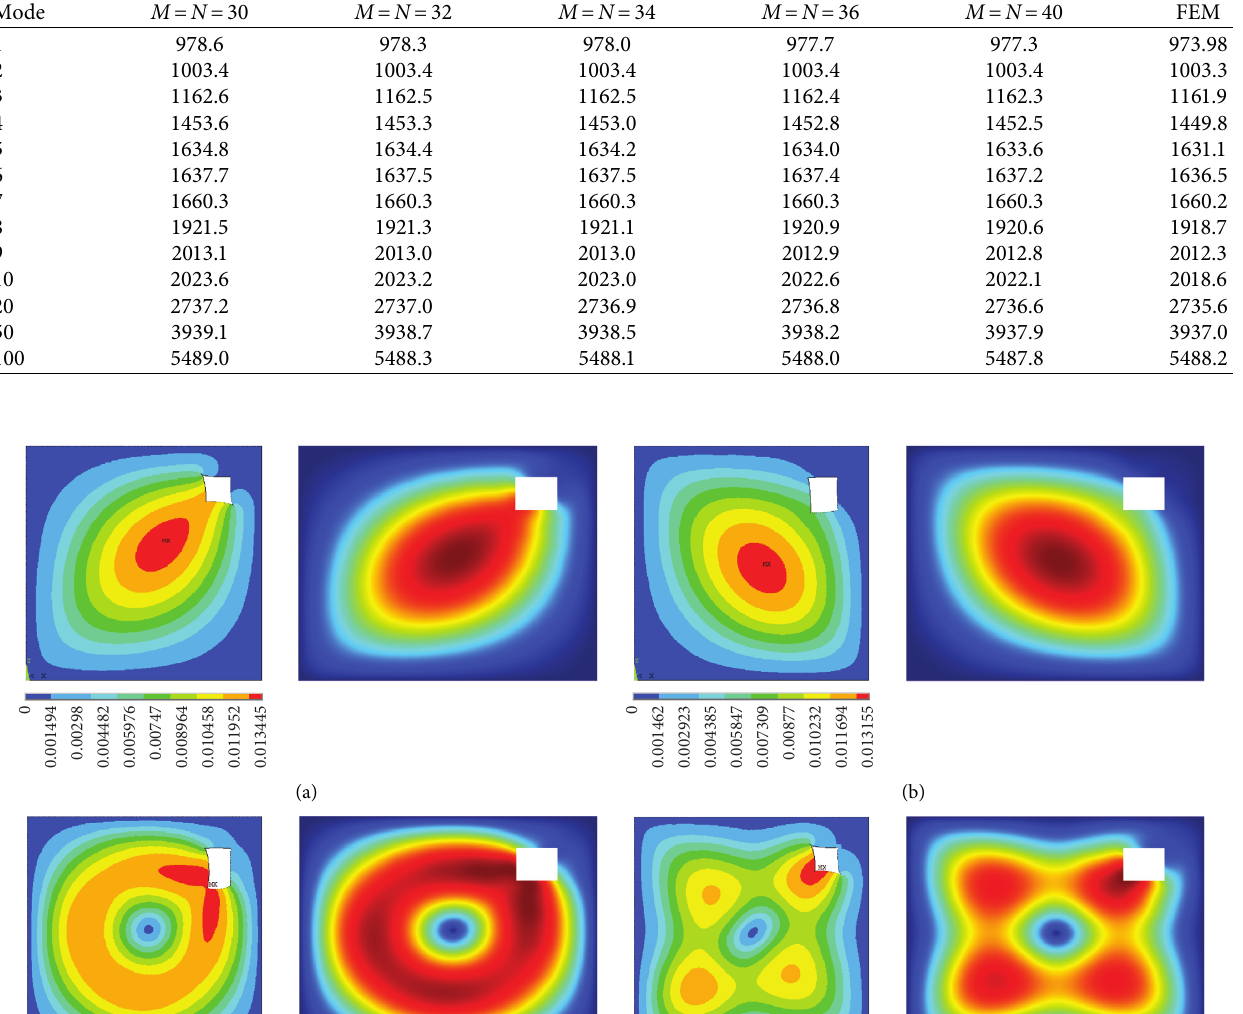
Table 1: The natural frequencies of the rectangular plate with an inner cutout.